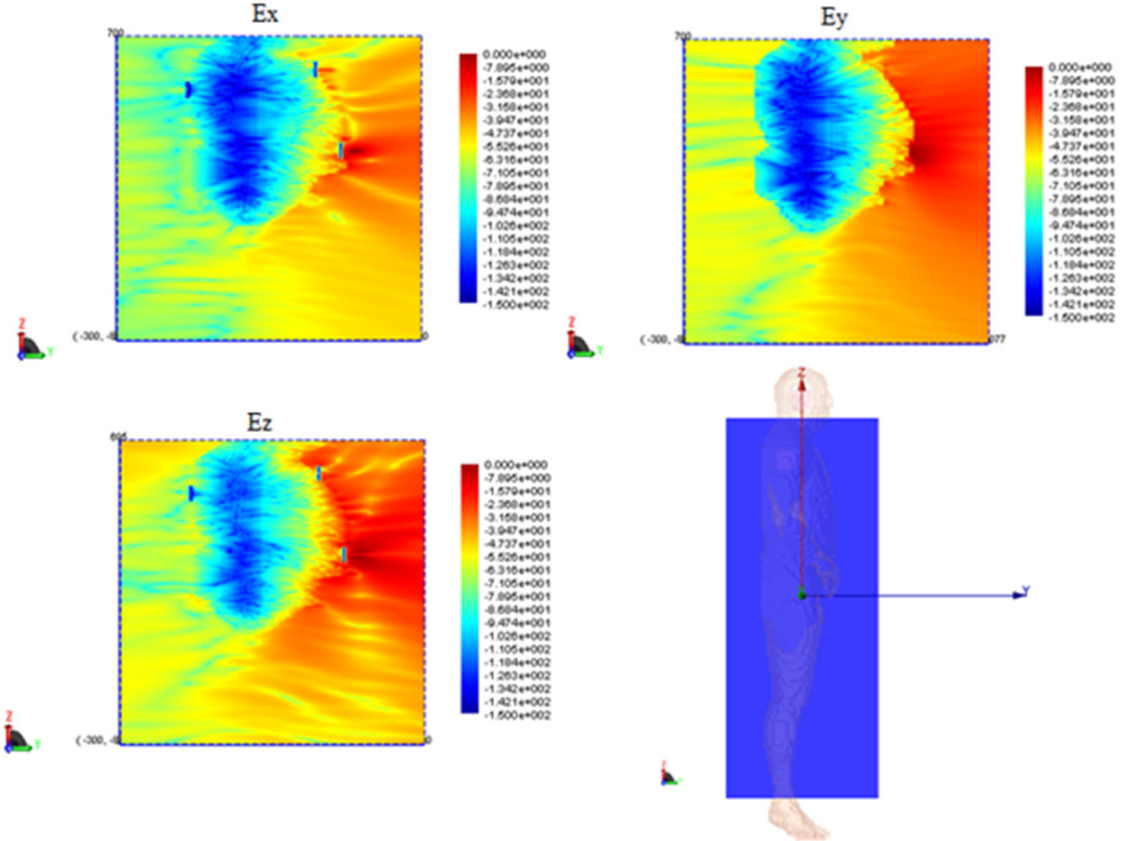
Figure 19. Electric field distributions (dB) on a vertical cut plane bisecting the body.